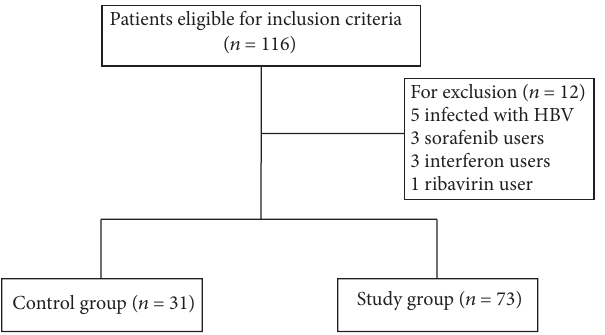
Figure 1: Flowchart for inclusion and exclusion